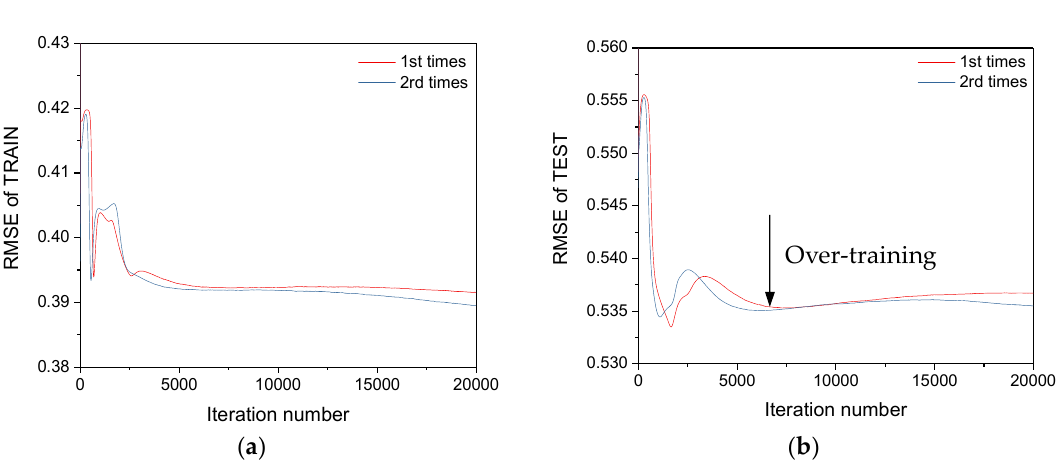
Table 2. The RMSE of errors produced by the ANN and PR models.